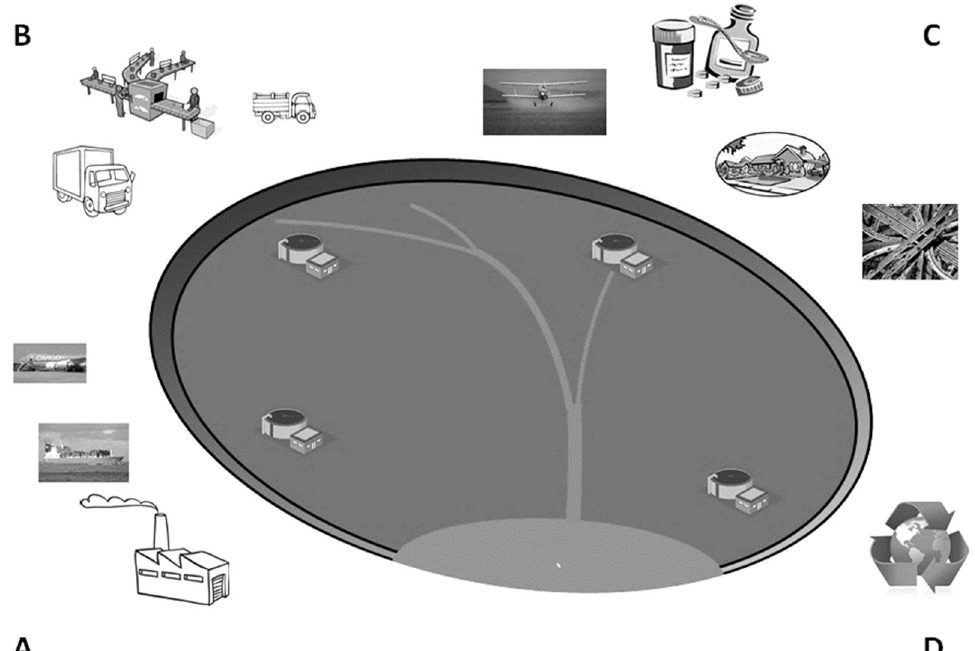
Fig. 1 In SimpleRisk releases of chemical substances are estimated for all chemicals based on different emission processes during the chemicals’ life cycle stages: manufacturing and transport ( A) , formulation and distribution ( B) , service life ( C) and recycling/waste stage ( D ). Release to the environment can take place mediated by (household or industrial) wastewater